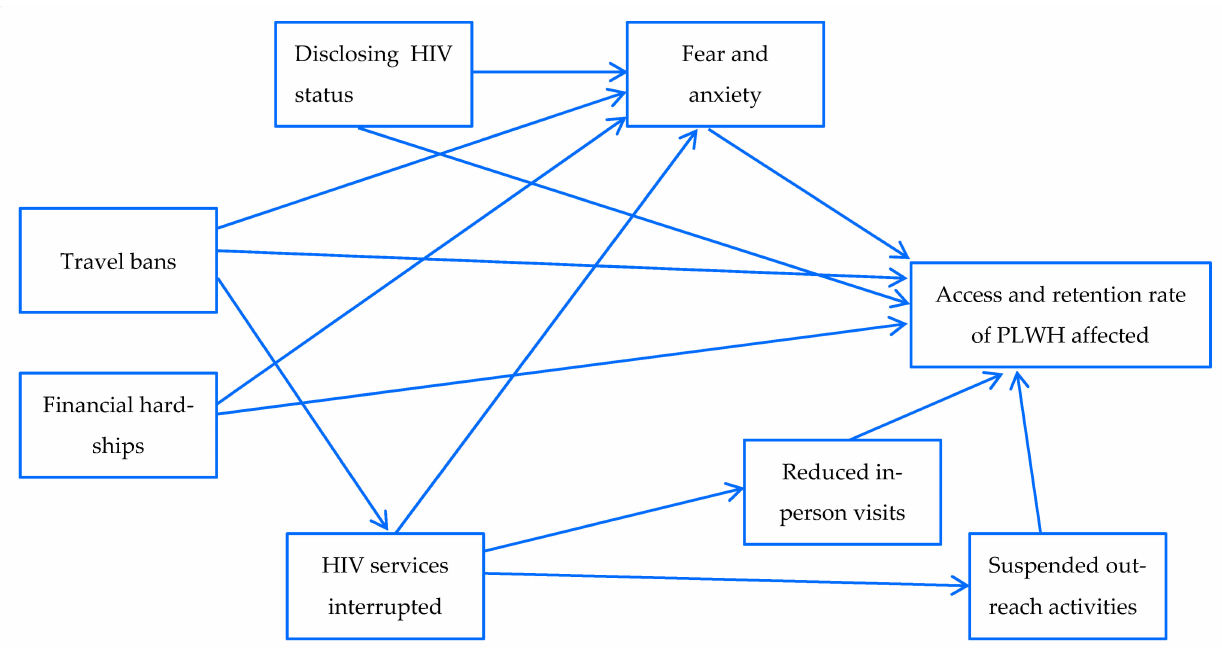
Figure 1. Diagram showing barriers to comprehensive HIV care during the COVID-19 pandemic among the PLWH interviewees, Cambodia CE research project (n = 69), Cambodia,